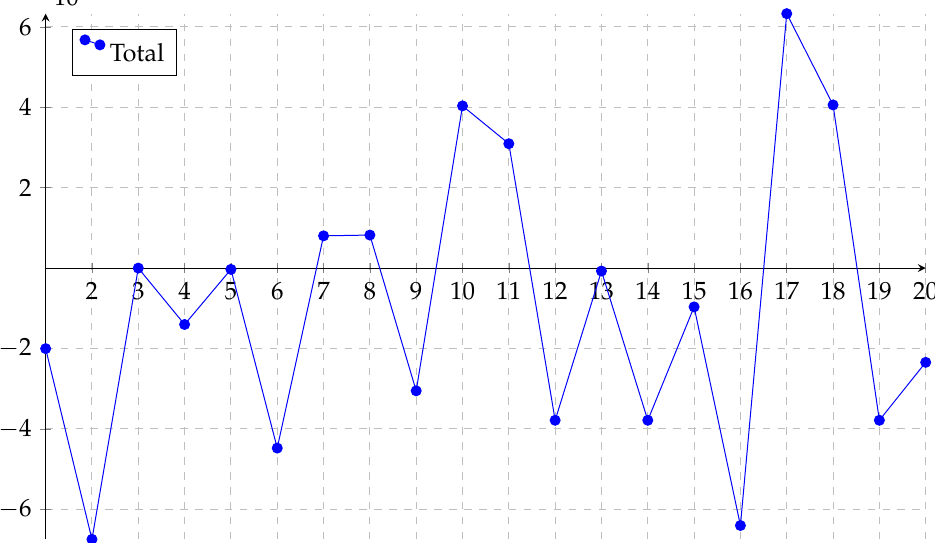
Figure 5. Differences in the amounts of financial compensation for three sets of substations.